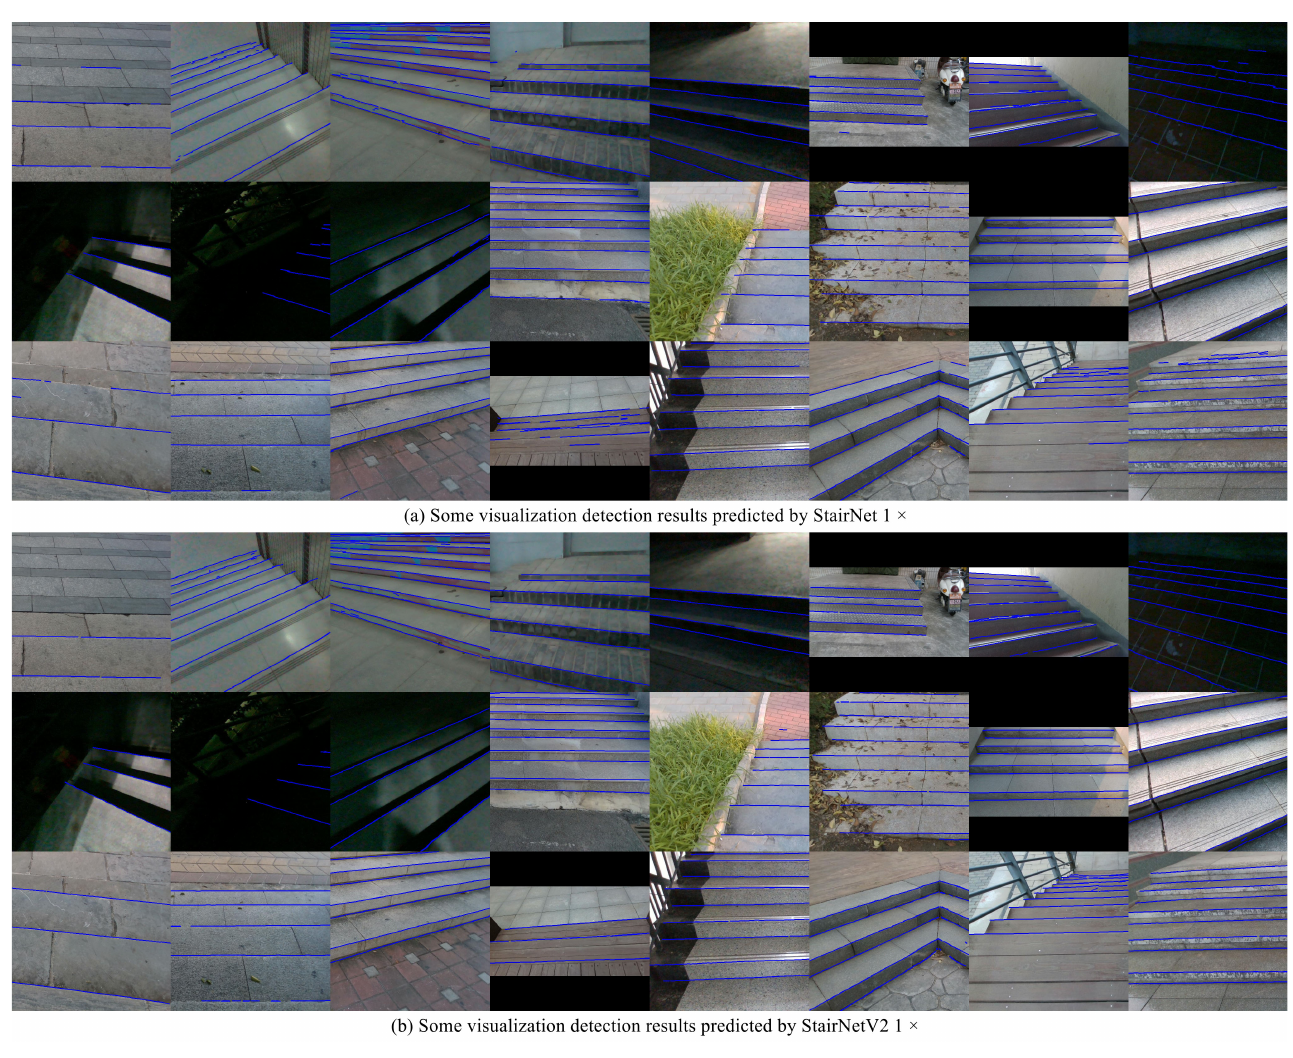
Figure 7. Some visualization detection results predicted by StairNet 1× and StairNetV2 1×.